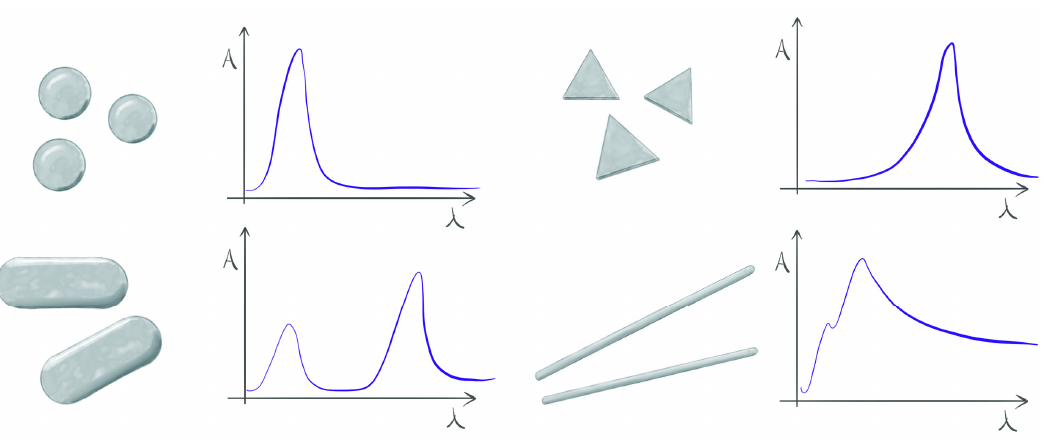
Figure 1. Schematic representation of the influence the morphology of metallic nanoparticles has on the shape of the plasmon resonance.